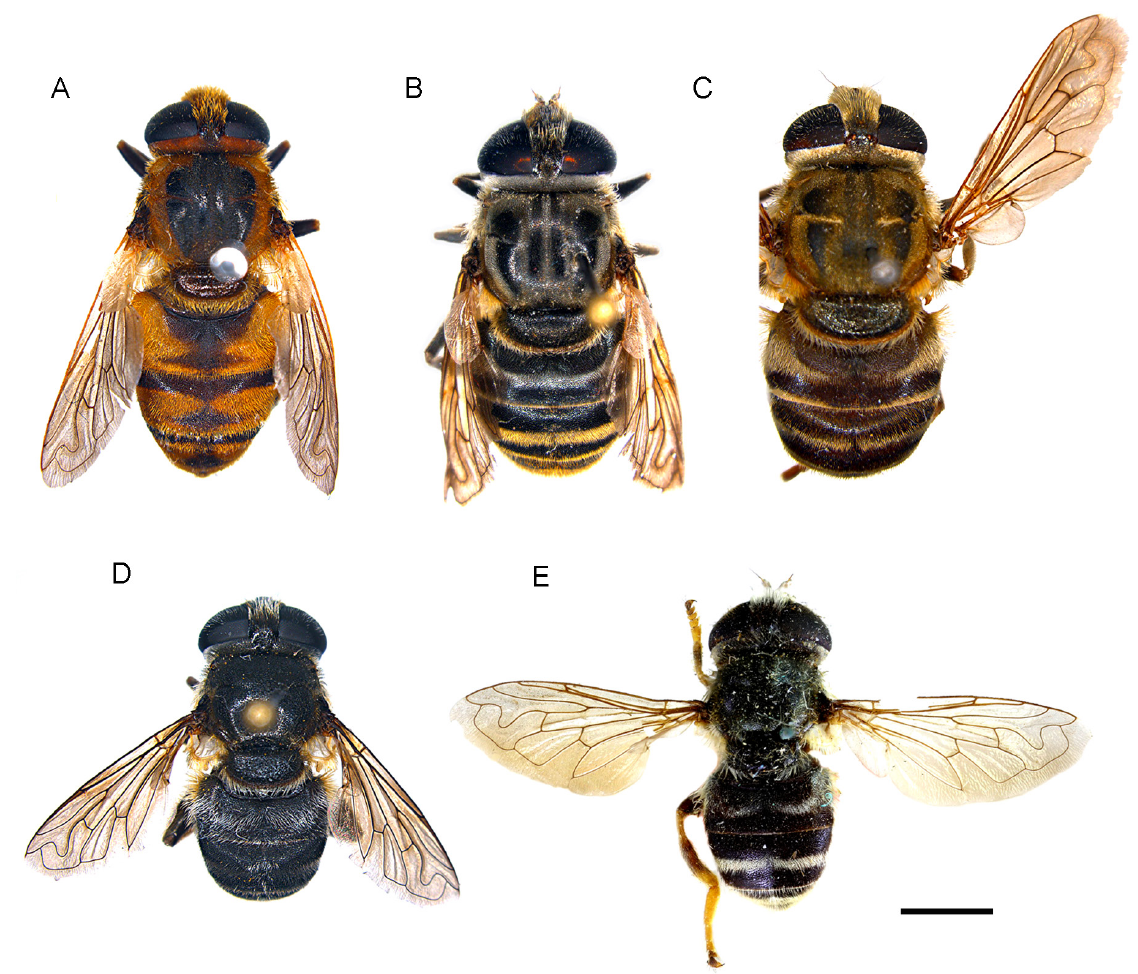
Fig. 14. Habitus of the female, dorsal view. A . Merodon bombiformis Hull, 1944 (NMSA; FSUNS ID 04278). B . M. multifasciatus Curran, 1939 (FSUNS; FSUNS ID ZA5_243). C . M. zebra Vujić & Radenković sp. nov., paratype (RMCA; FSUNS ID 25090). D . M. lotus Vujić & Radenković sp. nov., paratype (NMSA; FSUNS ID ZA6_067). E . M. nasicus Bezzi, 1915, lectotype (BMNH NHMUK010369943). Scale bar = 2